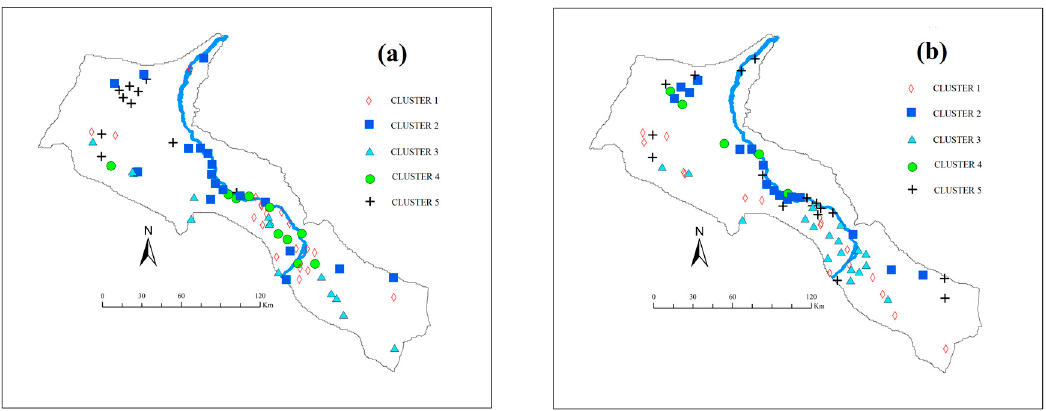
Figure 6. Spatial distributions of the clustered samples based on ( a ) GMM clustering; and ( b ) k-means clustering.